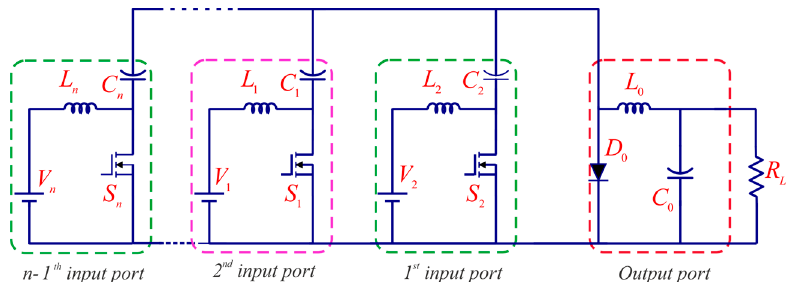
Figure 3. Generalized structure of the proposed ‘n’ port converter. Table 1. Comparison of circuit elements.